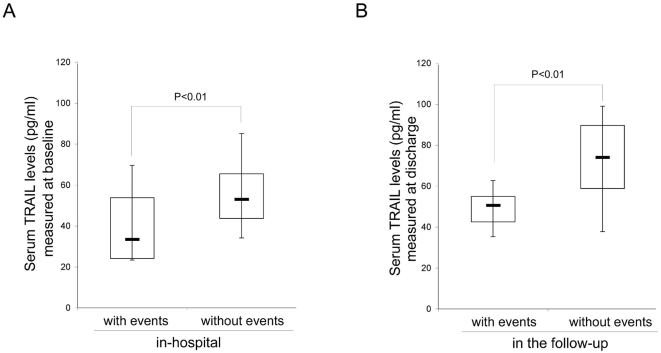
Serum TRAIL levels in AMI patient with respect to adverse clinical events.Serum levels of TRAIL were analyzed in AMI patient who died or experienced HF (with events) either during the acute phase (in-hospital) or in the follow-up (12 months after AMI) with respect to the other AMI patients (without events). Horizontal bars are median, upper and lower edges of box are 75th and 25th percentiles, lines extending from box are 10th and 90th percentiles.